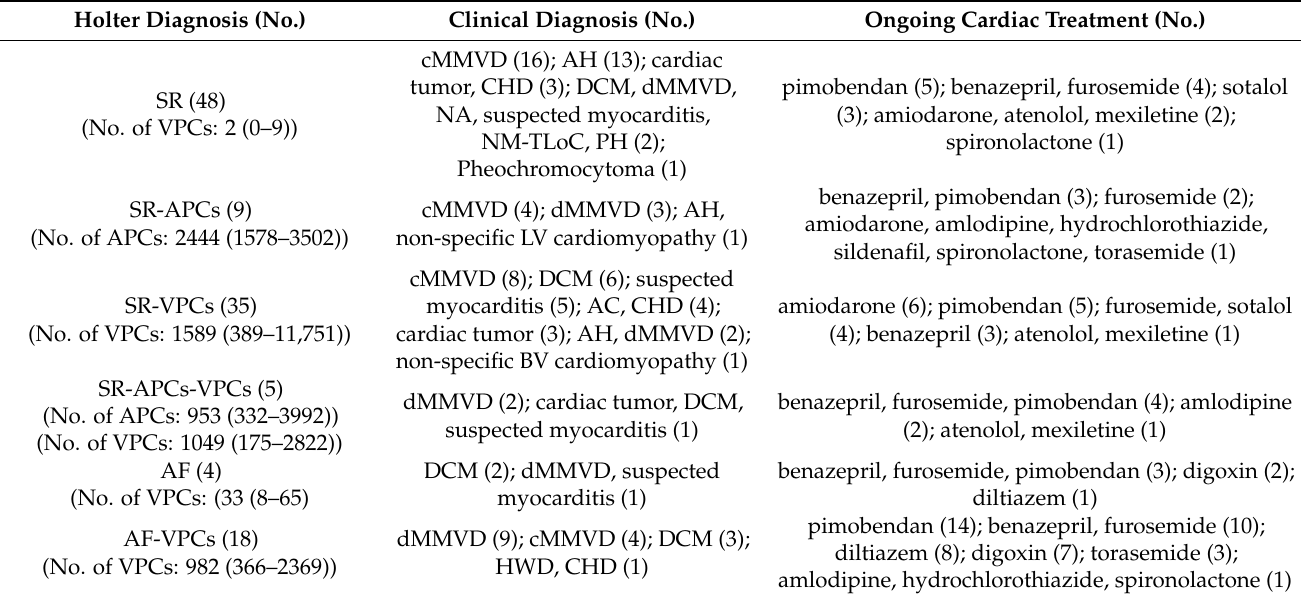
Table 3. Electrocardiographic, clinical, and treatment data related to Holter recordings used in this study. Holter Diagnosis (No.) Clinical Diagnosis (No.)